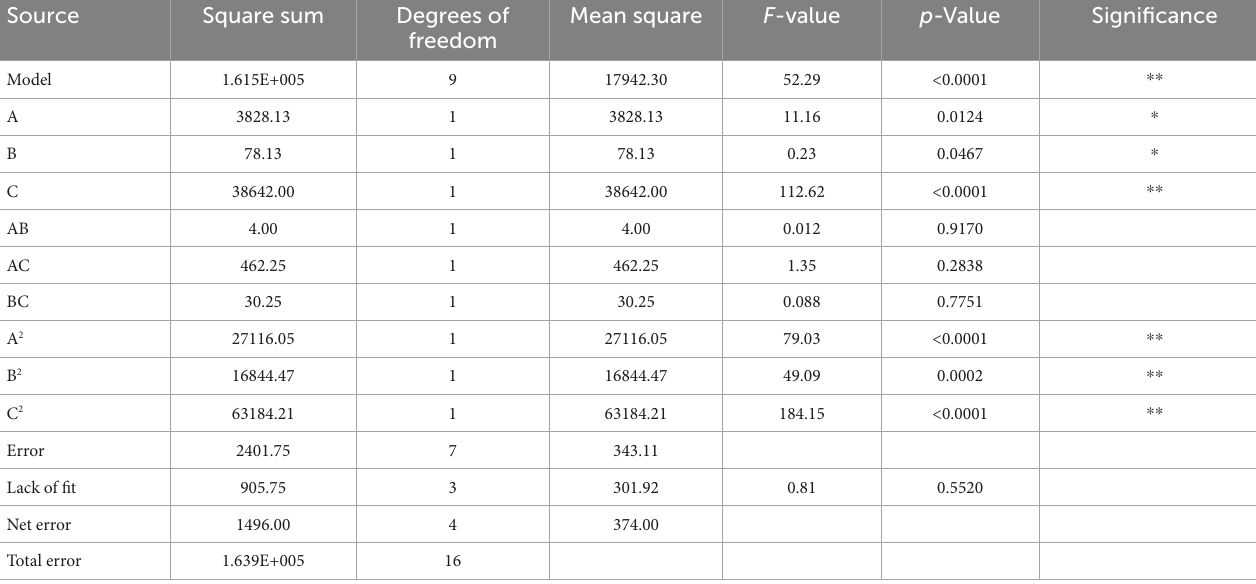
TABLE 2 Analysis of variance on the results obtained using single-factor experiment.